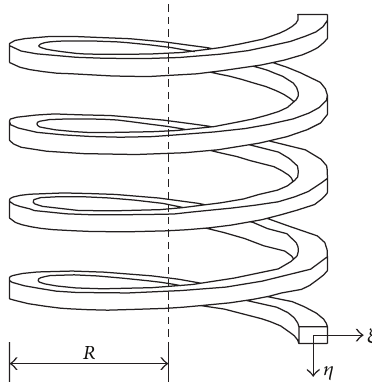
Figure 3: Cylindrical helical spring with rectangular cross